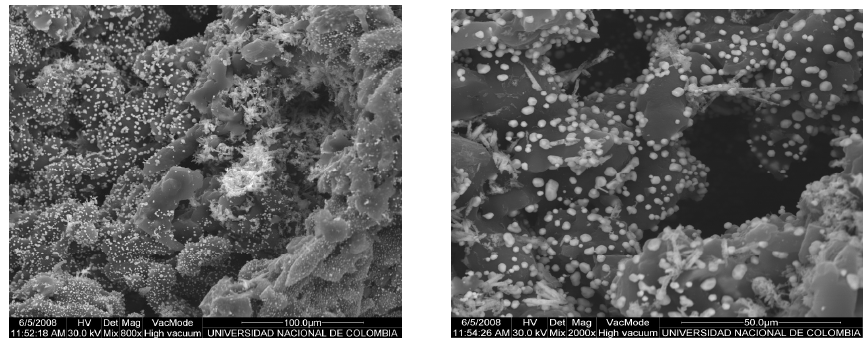
Figure 2 . (a) SEM Ni(II)ZSM-5 catalyst (b) SEM Cu-ZSM-5 catalyst.